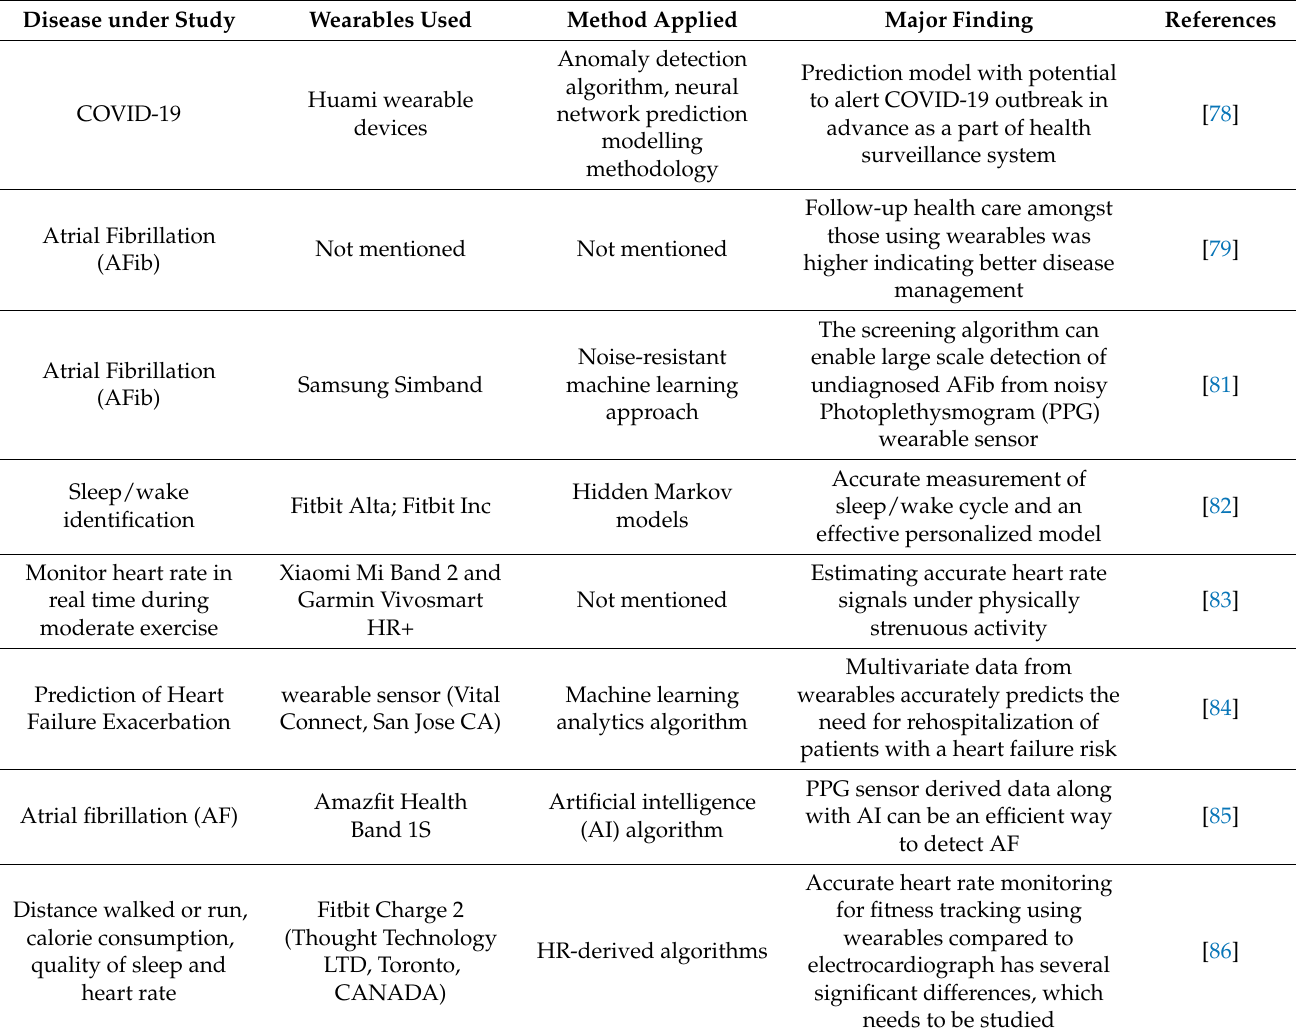
Table 2. Wearables-associated studies with clinical